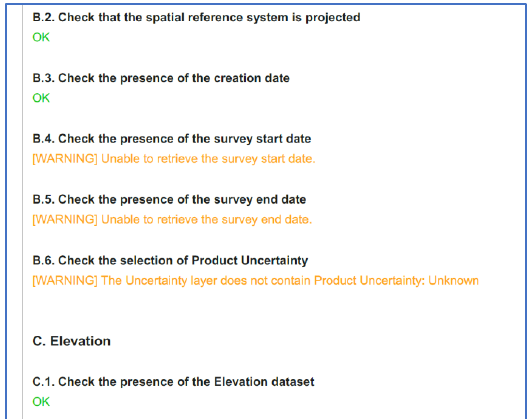
Figure 10. Extract from a PDF report generated by the BAG Checks tool. The report indicates which checks were performed and the results of the checks (passed checks in green, warnings in orange). At the end of the report, a summary indicates how many warnings and errors were identified for the surface.